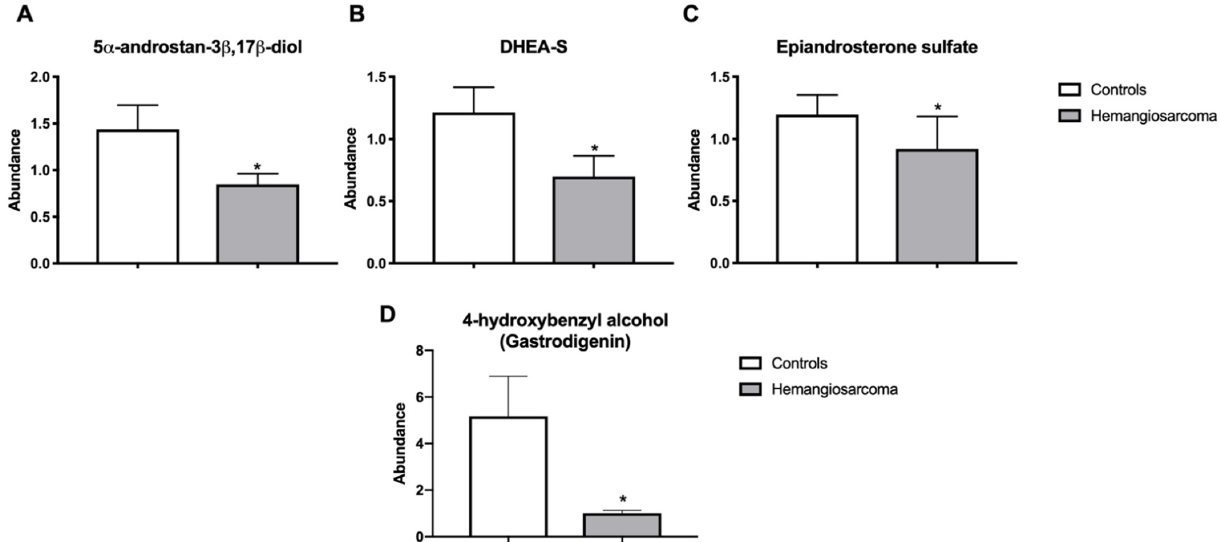
Figure 6. Steroid hormones, steroid hormone metabolites and gut-derived phenol gastrodigenin are diminished in VC- mediated hemangiosarcoma. Serum 5alpha-androstan-3-beta,17-beta-diol disulfate ( A ), Dehydroisoandrosterone (DHEA) sulfate ( B ), Epiandrosterone ( C ) and gastrodigenin ( D ) are plotted for Control and Hemangiosarcoma groups. Data are represented as mean ± SEM. * denotes significance with p < 0.05.